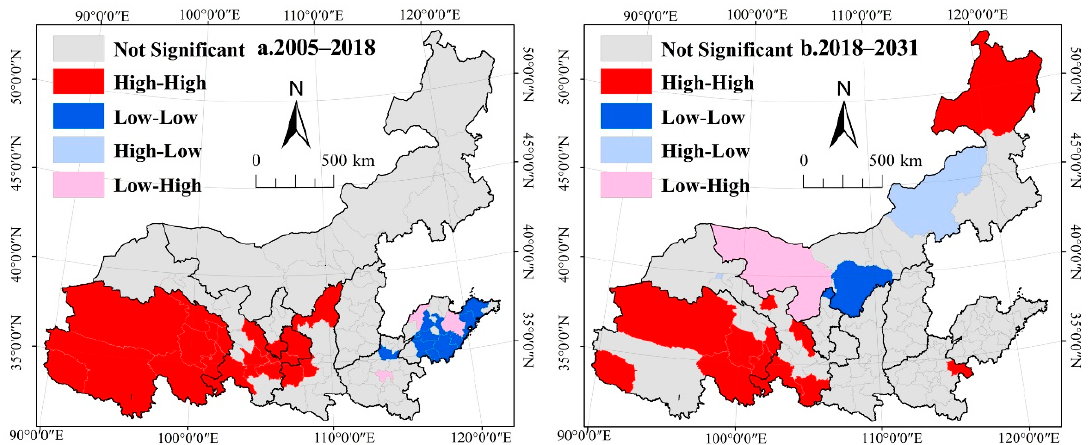
Figure 5. LISA cluster map of the rate of habitat quality change in the Yellow River Basin. ( a ). 2005–2018 represents the LISA cluster map of the rate of habitat quality change in the Yellow River Basin in 2005–2018; ( b ). 2018–2031 represents the LISA cluster map of the rate of habitat quality